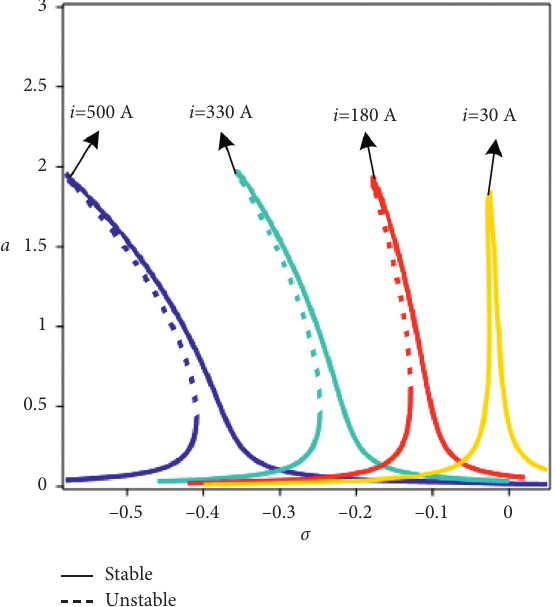
Figure 19: The 2-order super-harmonic amplitude-frequency re- sponse curves (varied i